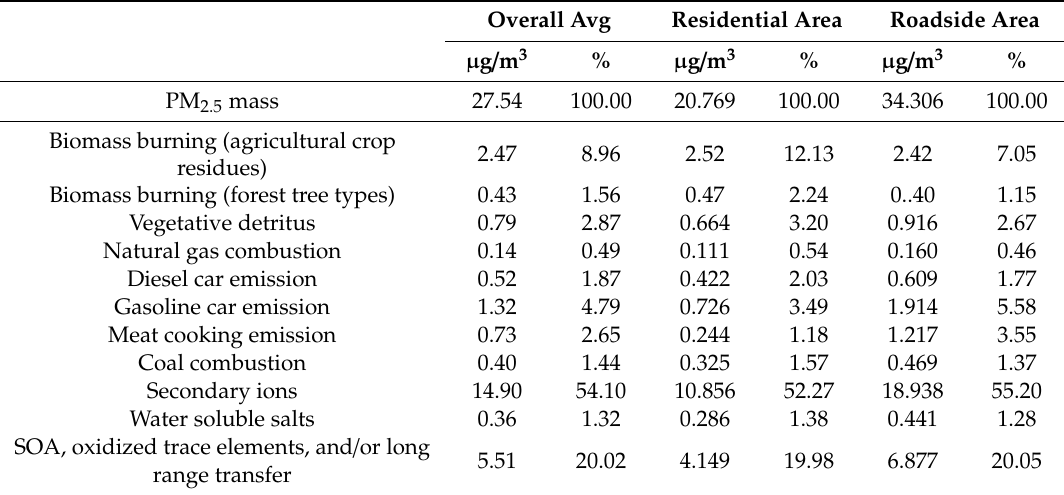
Table 5. Source apportionment results of PM 2.5